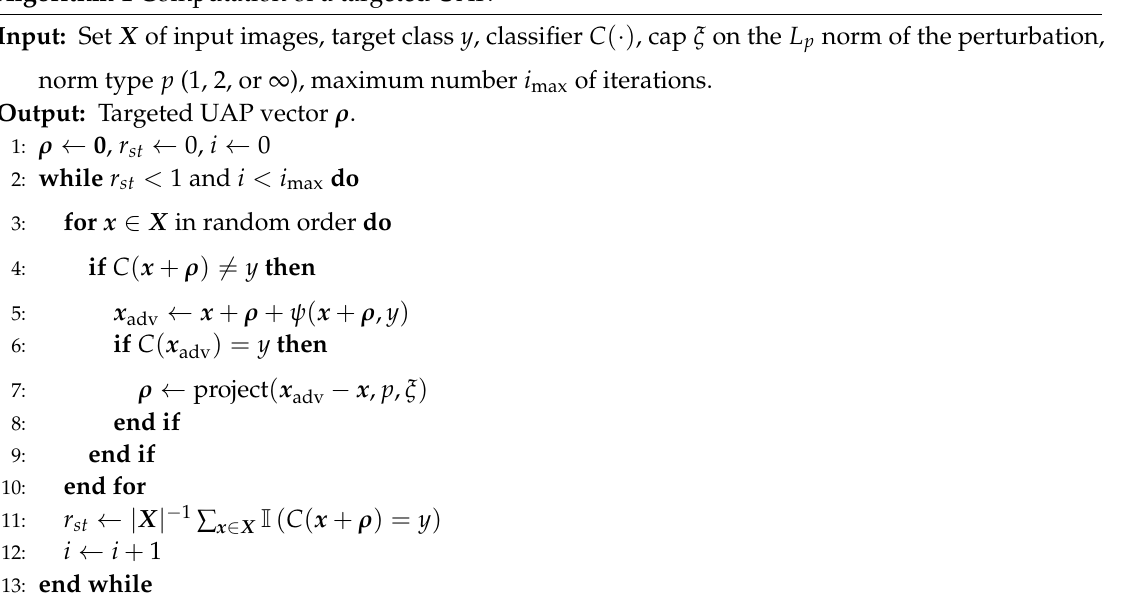
Algorithm 1 Computation of a targeted